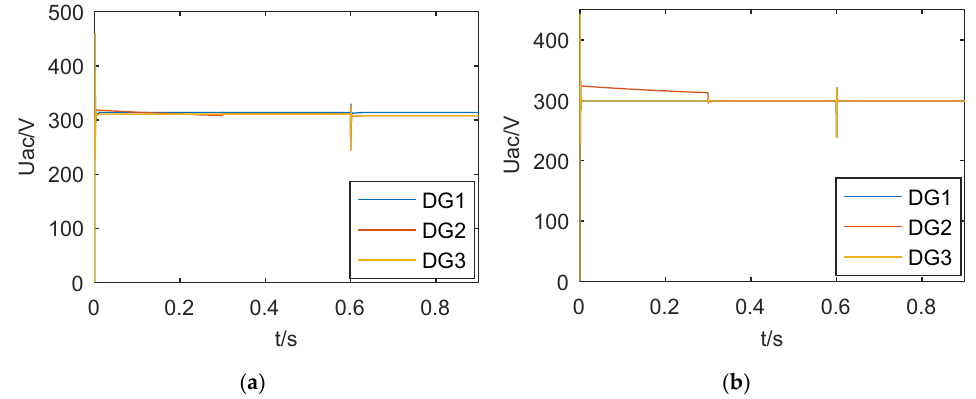
Figure 10. Voltage of each node of DC subnet. ( a ) Voltage of each node of DC subnet under traditional droop control. ( b ) Voltage of each node of DC subnet based on OPPRA.